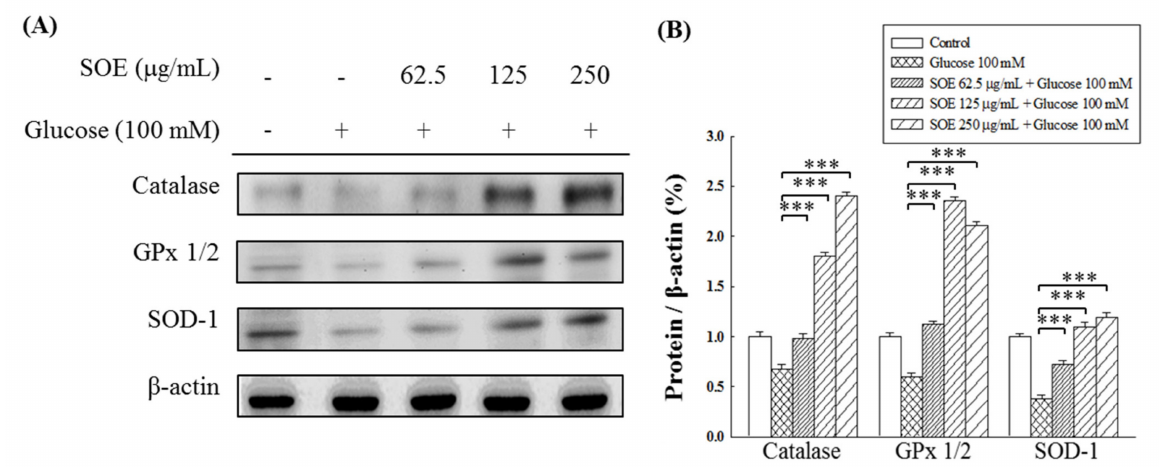
Figure 4. Effect of SOE on the production of antioxidant enzymes (catalase, GPx, and SOD) in RIN-m5f β -cells under HG stimulation. ( A ) Changes in protein expression of the three antioxidant enzymes. ( B ) Densitometric quantitation. The β -cells were cultivated for 24 h and then treated with various concentrations of SOE for 24 h under the stimulation of 100 mM glucose. The obtained cell extracts were subjected to electrophoresis on SDS-PAGE gel, followed by an enzyme immunoassay and ECL for detection. The internal standard was β -actin. Densitometric analysis was also performed. The experimental data were calculated from the results of three repeated experiments. The statistically significant differences compared with the vehicle (group 0) are expressed as *** p < 0.001.